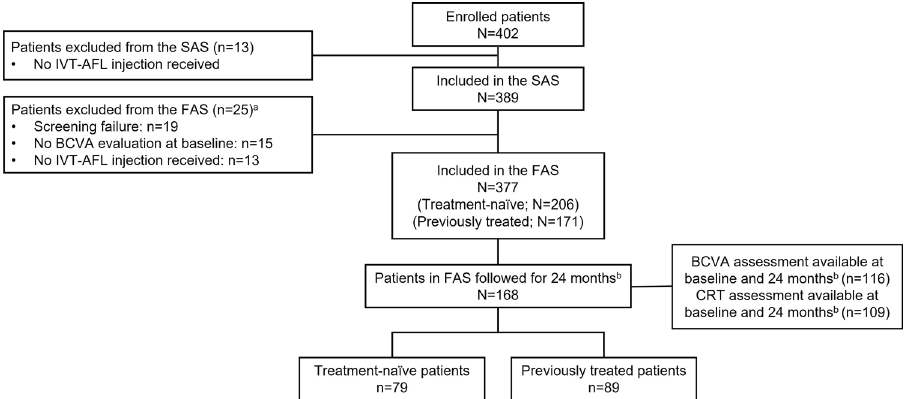
Figure 1. Patient disposition. BCVA, best-corrected visual acuity; CRT, central retinal thickness; FAS, full analysis set; IVT-AFL, intravitreal aflibercept; SAS, safety analysis set. a Patients could have been excluded from the FAS for more than one reason. b Patients had follow-up data available to at least 23 months, with a visit, injection, BCVA assessment, or optical coherence tomography evaluation between 23 and 25 months from the first IVT-AFL